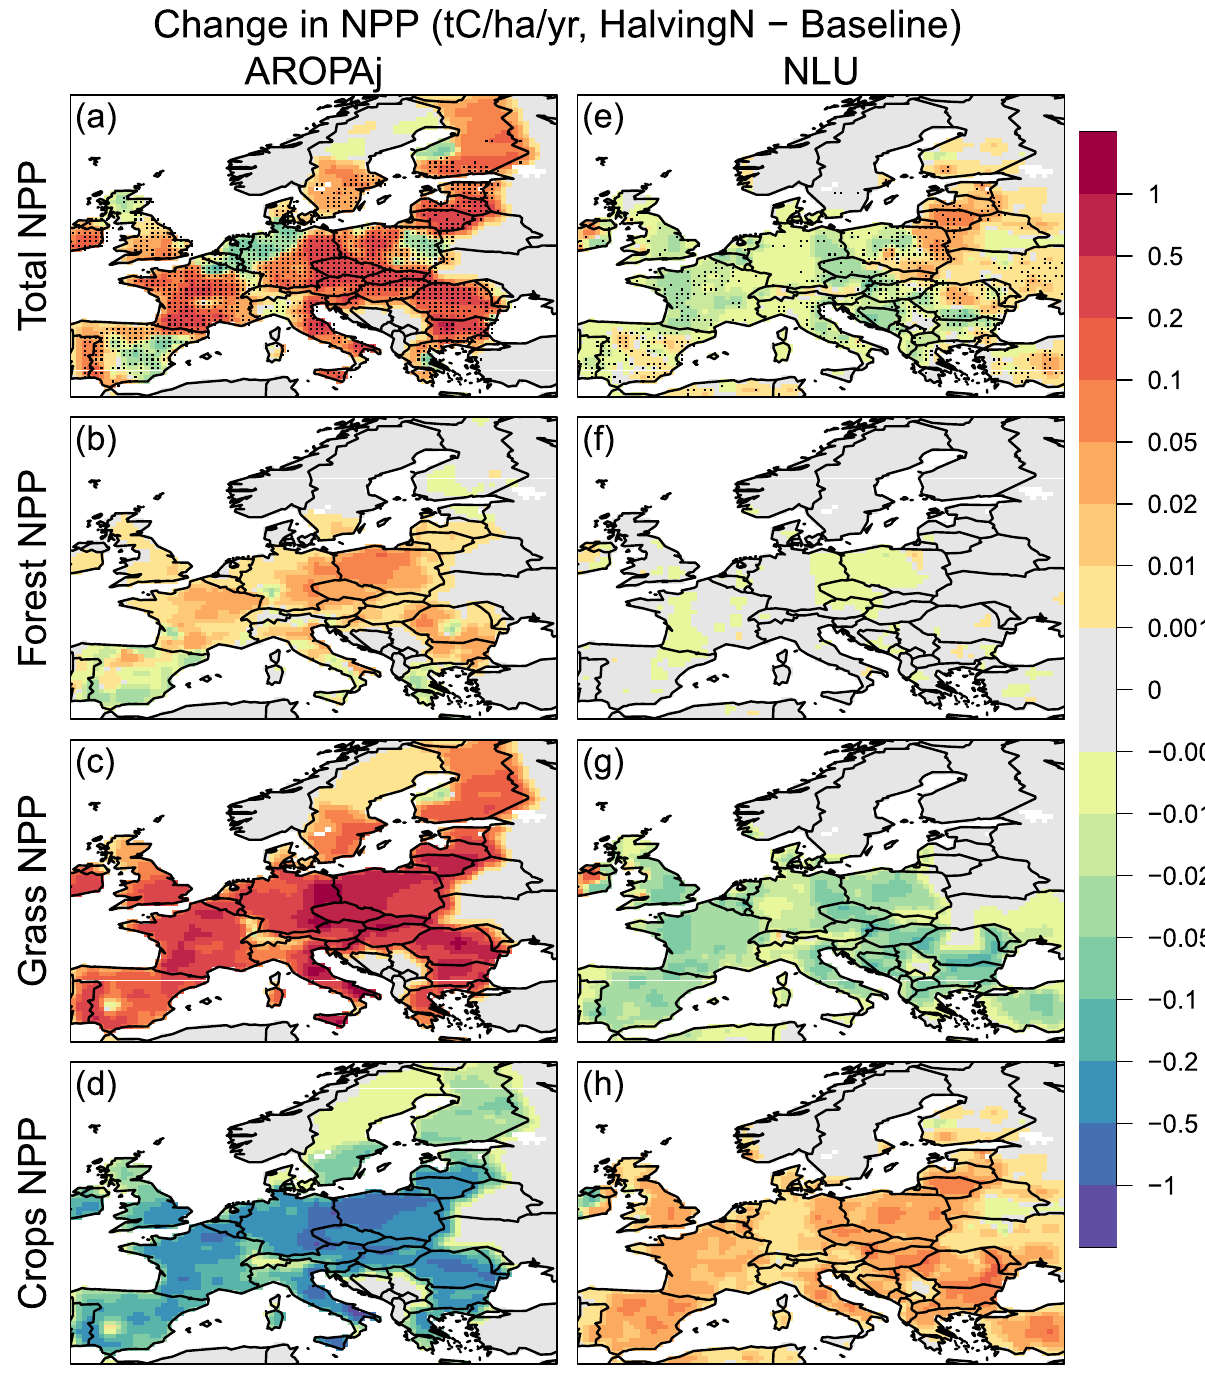
Figure 2. ORCHIDEE-crop model simulated annual mean change in ( a , e ) total NPP (tC ha −1 year −1 ), ( b , f ) Forest NPP, ( c , g ) Grass and Pasture NPP, and ( d , h ) Crop NPP due to 50% reduction in N fertilizer. The mean changes are computed using the last 50-years’ means of the 100-year simulations. The change in NPP shown here is the weighted sum across all PFTs. Stippled areas are regions where changes are statistically significant at the 95% confidence level. Significance level is estimated using a Student’s t-test with a sample of 50 annual mean differences and standard error corrected for temporal serial correlation. This figure is created using software R version 3.6.0 (https:// www.r- proje ct.